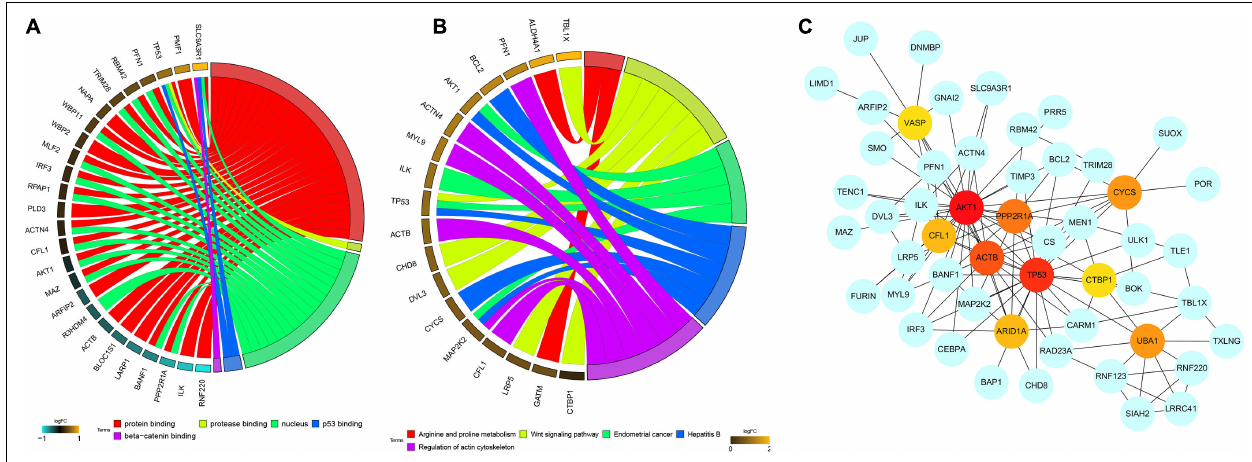
FIGURE 3 | Functional enrichment analysis, including (A) GO enrichment analysis and (B) KEGG enrichment analysis, and (C) PPI network construction of the red module. GO, gene ontology; KEGG, kyoto encyclopedia of genes and genomes; PPI, protein-protein interaction network.